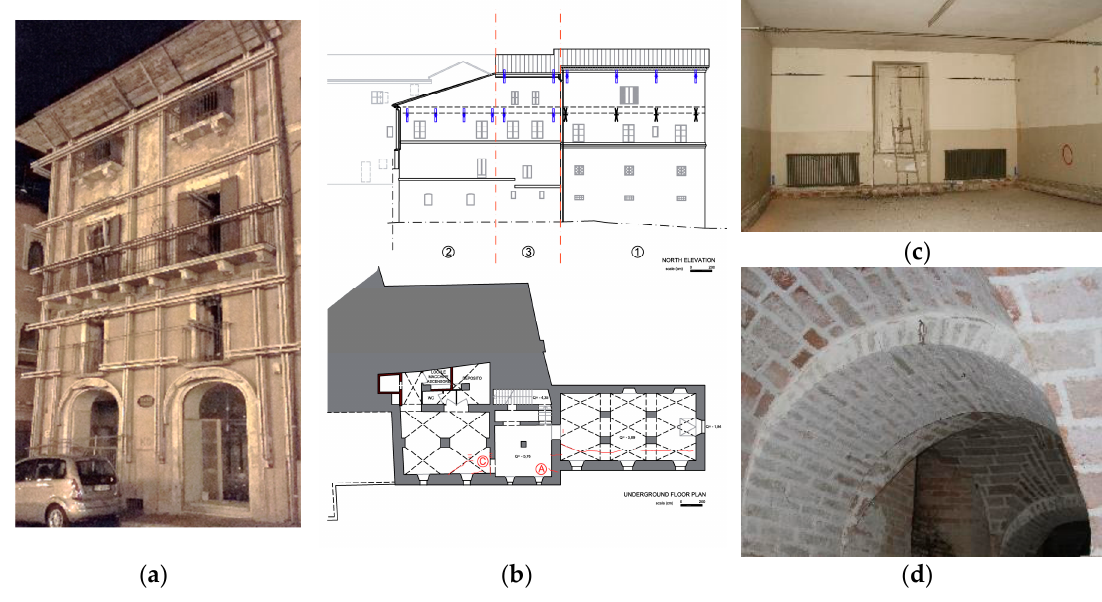
Figure 3. Example of massive safety intervention: ( a ) in a palace in L’Aquila and ( b ) in a palace in Recanati, where ( c ) all iron tie-rods are visible inside a room and ( d ) new cracks formed in the vaulted basement.